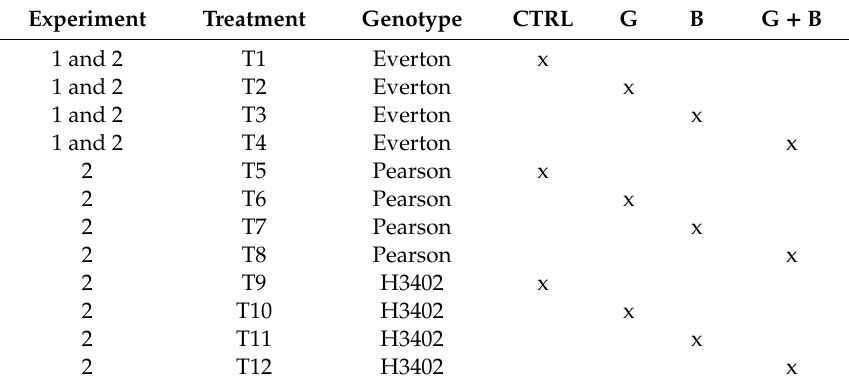
Table 1. Beneficial microorganisms and genotypes used in the